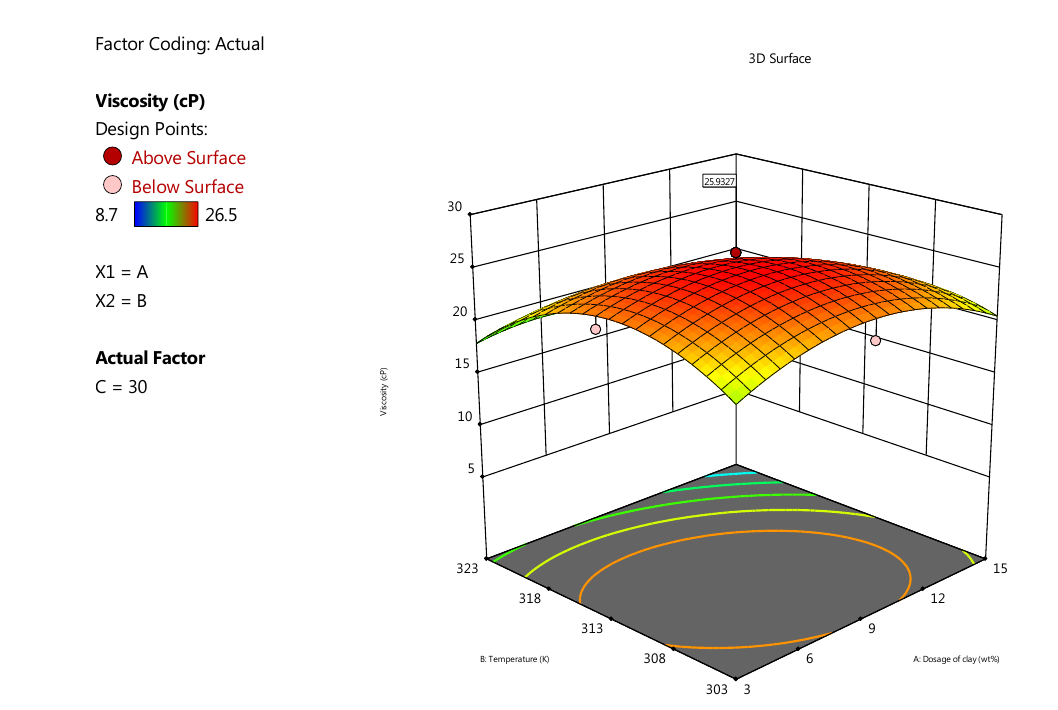
Figure 7. Effect of temperature and dosage of clay on viscosity of